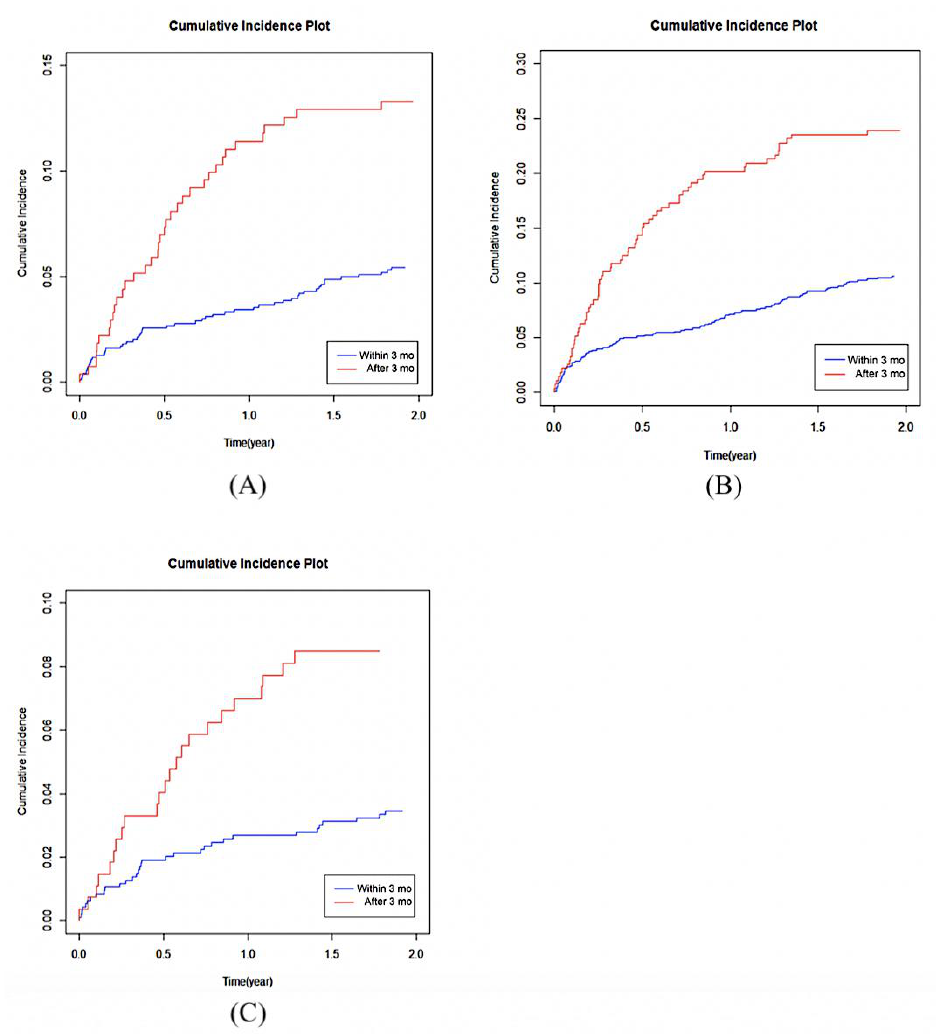
Figure 3. Cumulative incidence of ( A ) second fragility fracture, ( B ) second fragility fracture surgery, and ( C ) revision surgery in patients with bisphosphonate initiation within 3 months after fragility fracture surgery versus more than 3 months after fragility fracture surgery.